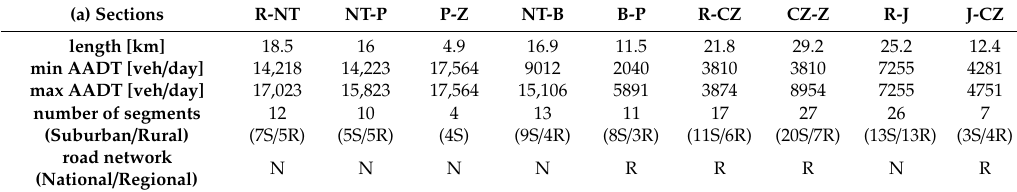
Table 3. Description of the analyzed road network covered by the TTIS by section.